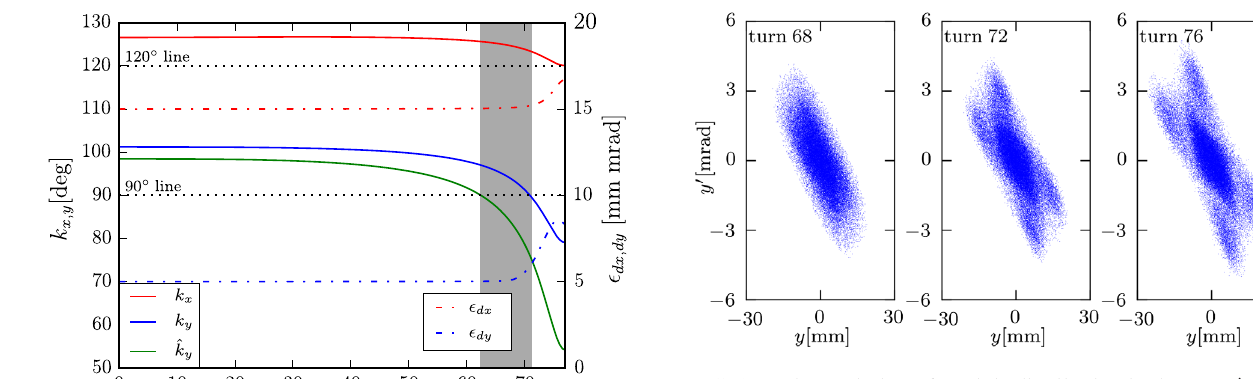
FIG. 9. The evolution of particle distribution in the y − y 0 phase space at final stage of bunch compression with double bunch intensity at 68th, 72nd, 76th turns during bunch compression. FIG. 7. Space-charge depressed phase advances k (solid x;y lines) solved from the coupled envelope approach and emittance growth ϵ (dashed lines) from PIC simulations during bunch dx;dy compression with doubled bunch intensity. (Shaded area denotes 90 ° to ˆ k 90 °.) the range from k y ¼ y ¼ bunch compression is due to the fourth-order resonance, and no envelope instability is observed in PIC simulations.